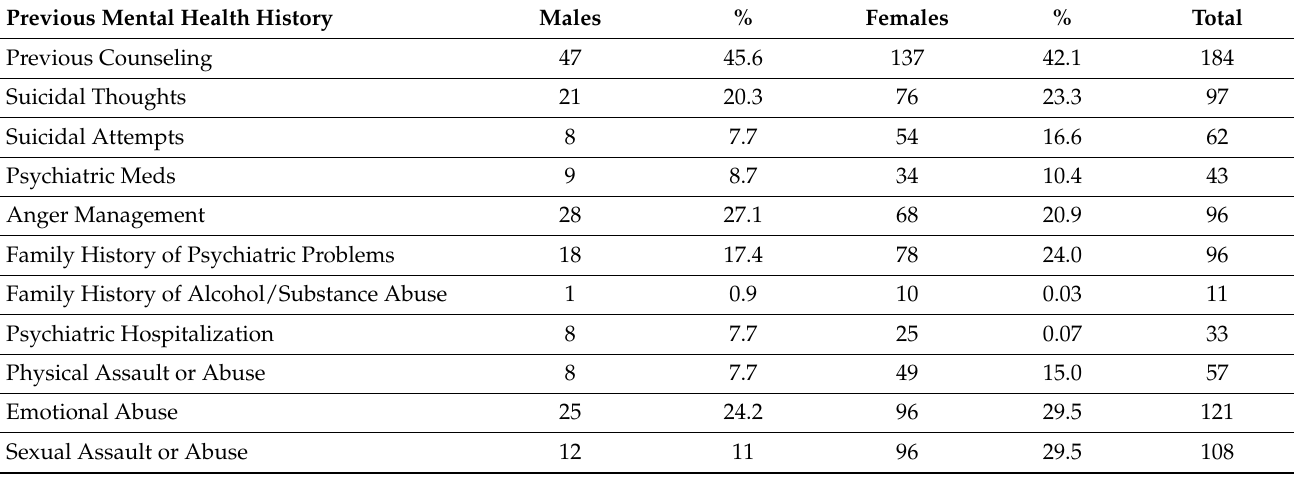
Table 3. Past Mental Health